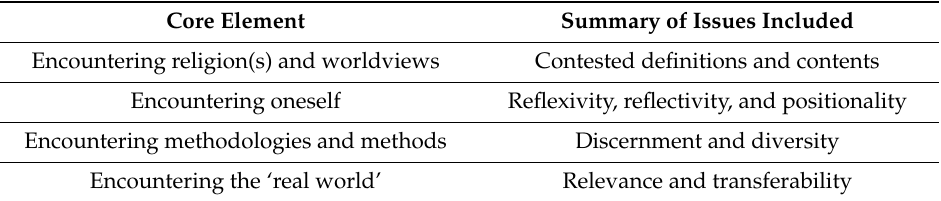
Table 3. Core elements in studies of religion and worldviews in Freathy and John